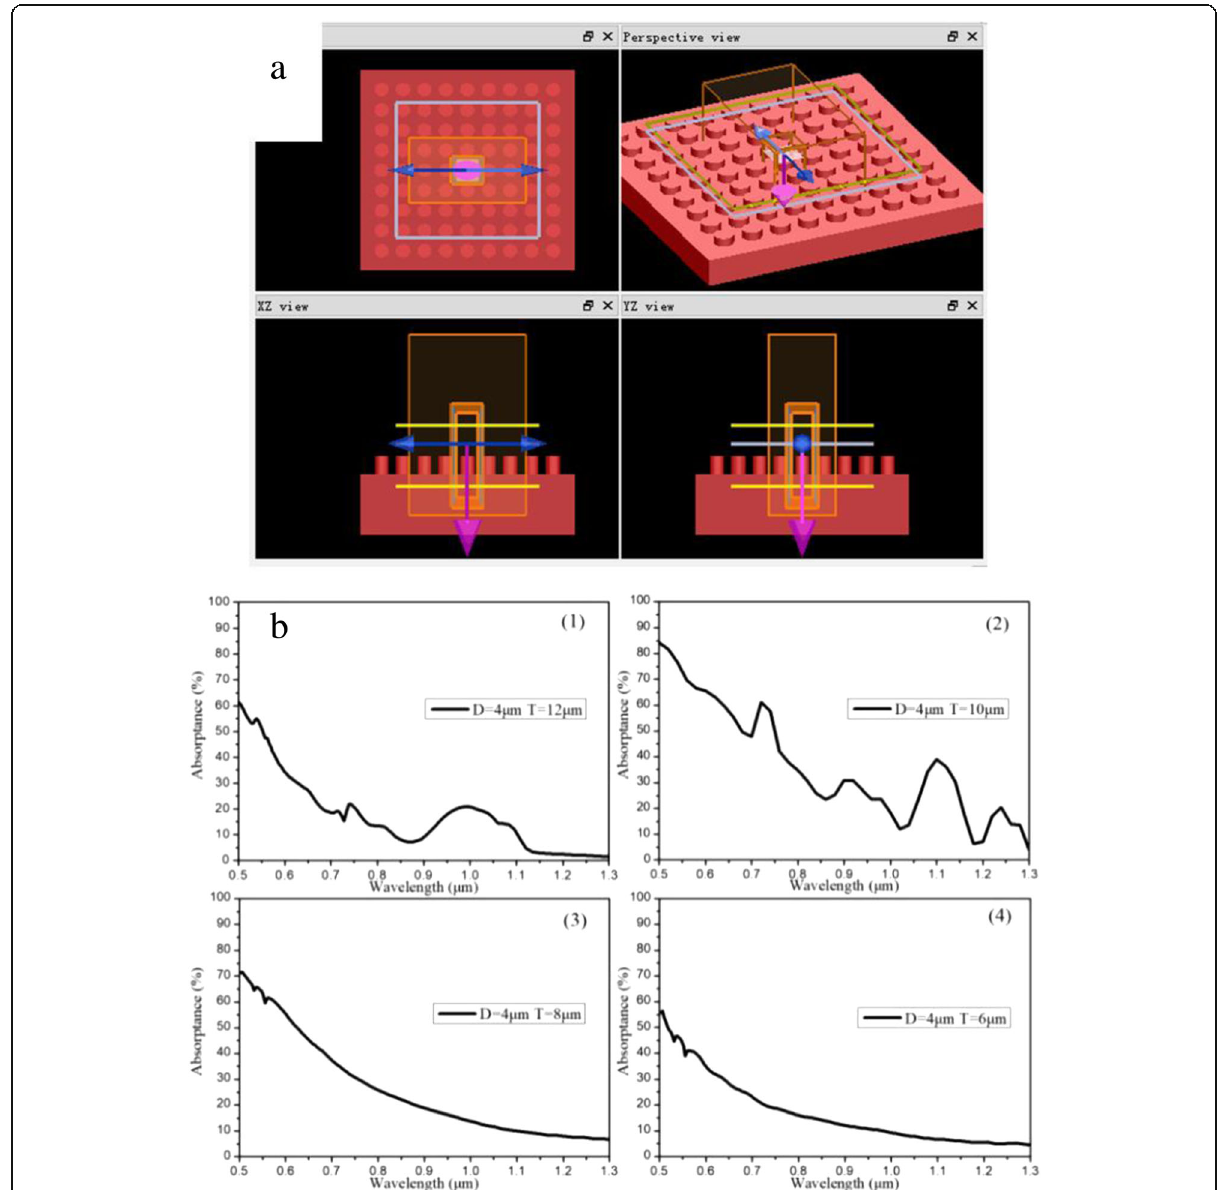
Fig. 1 Optical simulation model ( a ) and simulation results ( b ) of microstructured